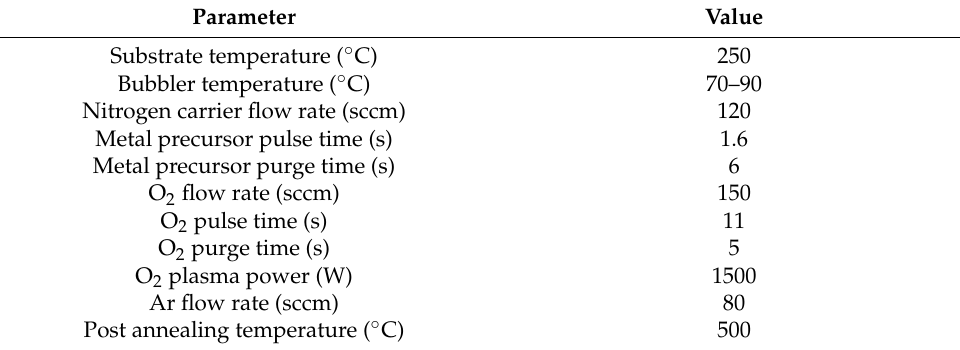
Table 1. Deposition parameters of the PEALD Ta-doped TiO 2